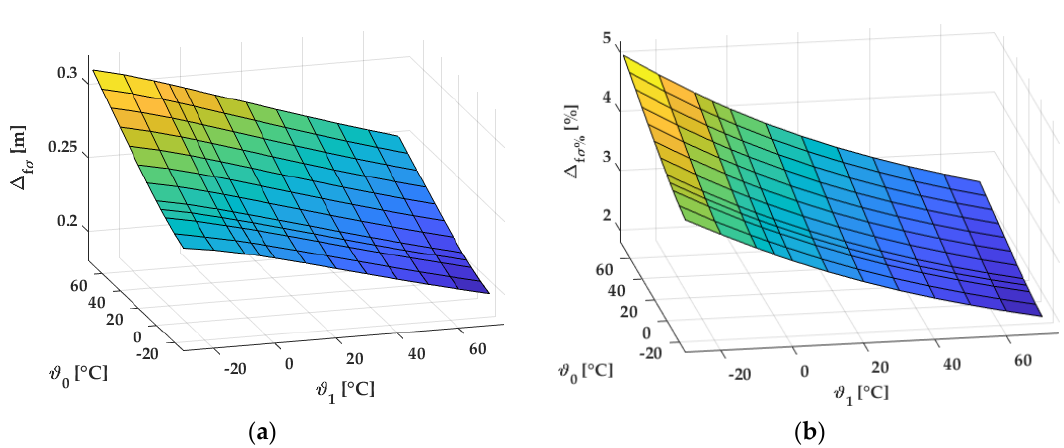
Figure 11. The dependence of sag deviations caused by the incorrect determination of the conductor initial mechanical tension due to the point cloud inaccuracy: ( a ) Absolute sag deviations; ( b ) percentage sag deviations.